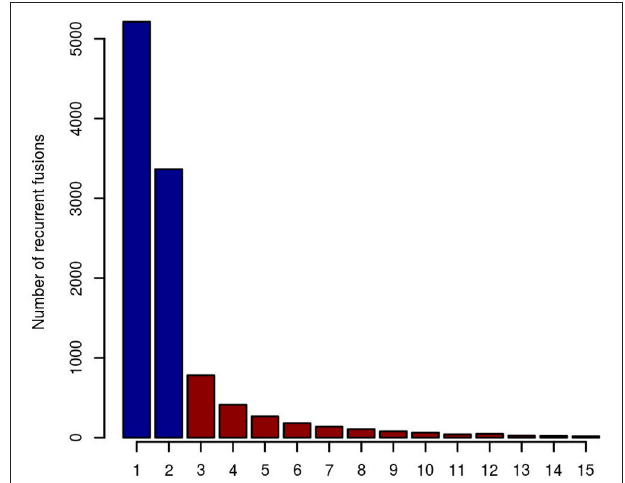
contained in the artifact list to be of high false positive rate. FIGURE 2 | The number of recurrent fusion genes in 15 different entities. Fusions identified in more than two entities were selected for the final artifact list, resulting in 2,190 artifact fusions labeled with red